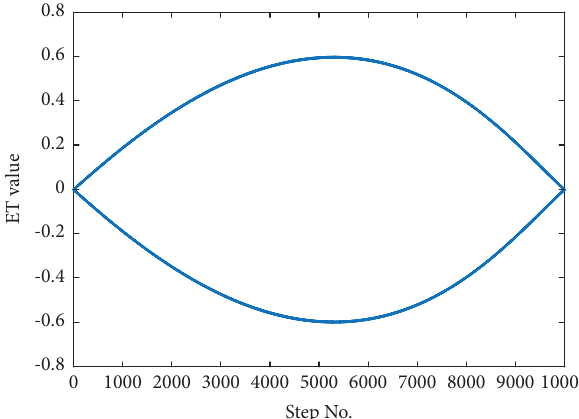
Figure 2: Te maximum and minimum values of ET.